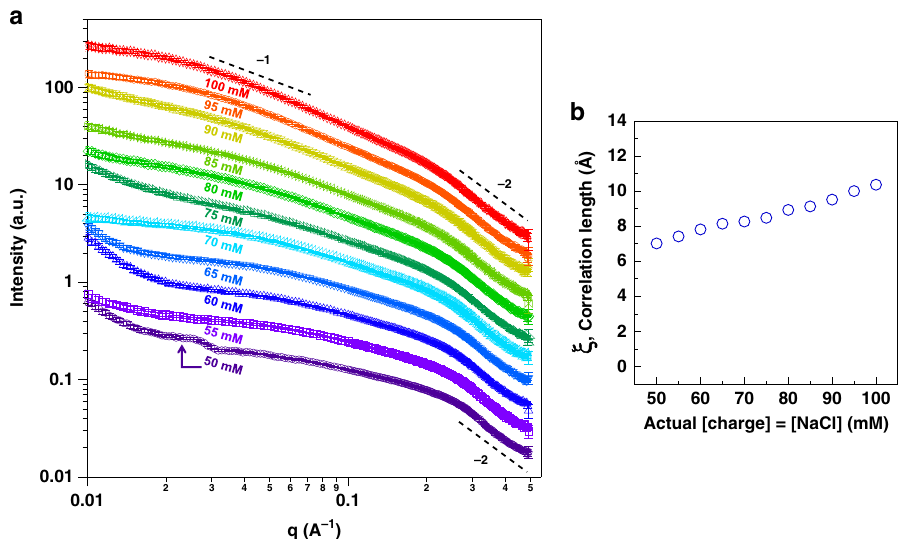
Fig. 6 SAXS data of complex coacervate mimics samples. a Small-angle X-ray scattering plots of PDADMA/PAA complex coacervate samples prepared at 50 – 100 mM polymer charge and NaCl, with HEPES ranging between 25 and 50 mM, and MgCl 2 between 4.3 and 8.6 mM for the same samples. The data were shifted vertically for clarity (Supplementary Fig. 26a shows the data without vertical shift). Error bars represent noise in the scattering measurements. b Correlation length, ξ , obtained from the Uni fi ed fi t in the high-q region of the SAXS plots. The individual fi ts are shown in Supplementary Fig. 26b. Error bars obtained from fi ts were smaller than the markers and were not included. Their values can be found in Supplementary Table 11.